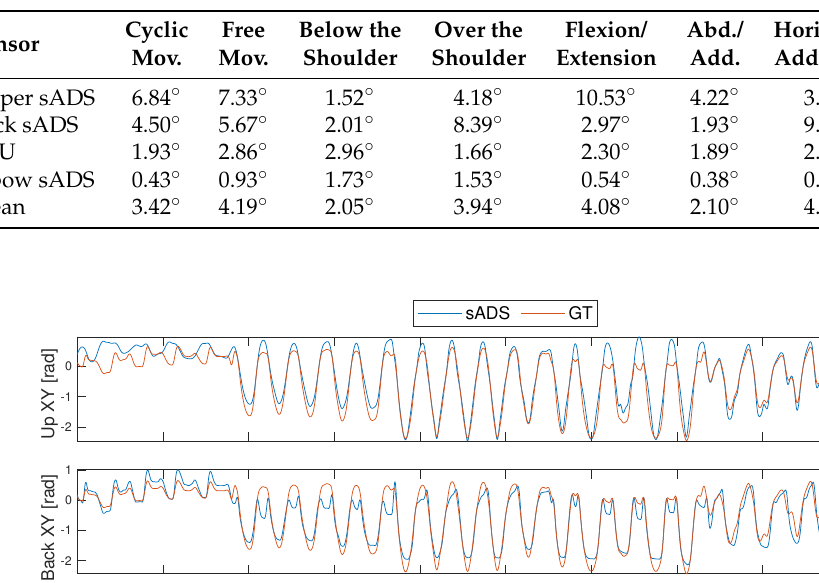
Table 5. Orientation error in root-mean-square error (RMSE) obtained by the ground truth system (GTS) when performing the movements and gestures. Elbow orientation error was compared even in gestures that did not involve elbow movement.